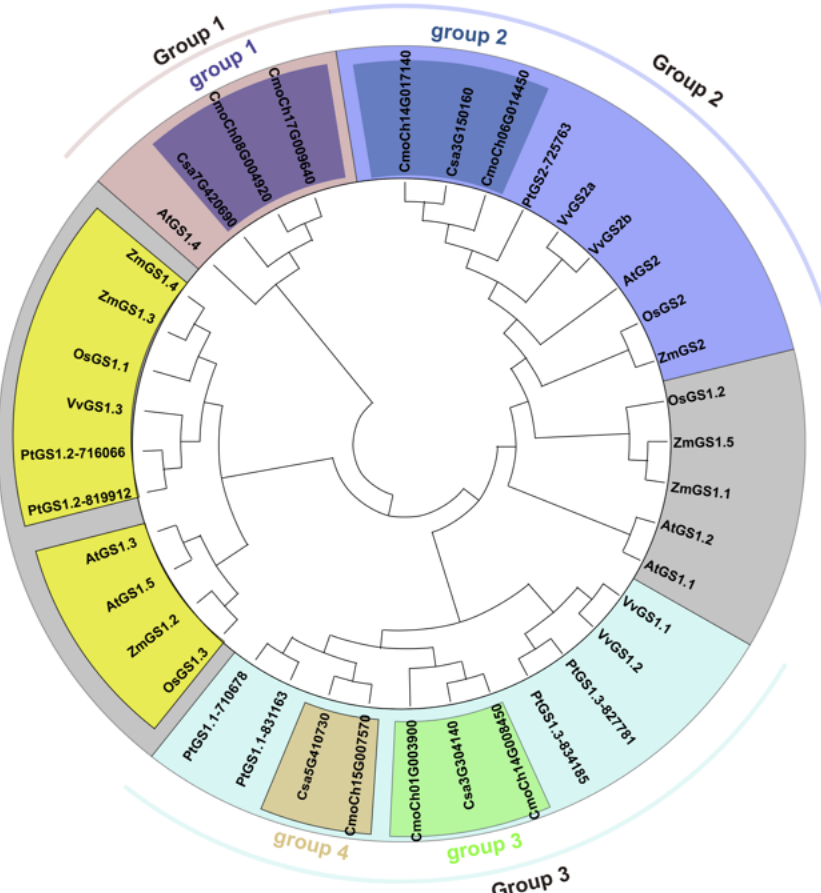
Figure 1. Phylogenetic tree of glutamine synthetase ( GS ) family genes in pumpkin, cucumber, grape, rice, poplar, maize, and Arabidopsis . The phylogenetic tree was constructed by the neighbor-joining method, with 1000 bootstrap repeats. The three classifications and four subfamilies are represented by different colors. Pt: Populus trichocarpa . Os: Oryza sativa . Vv: Vitis vinifera . At: Arabidopsis thaliana . Zm: Zea mays.